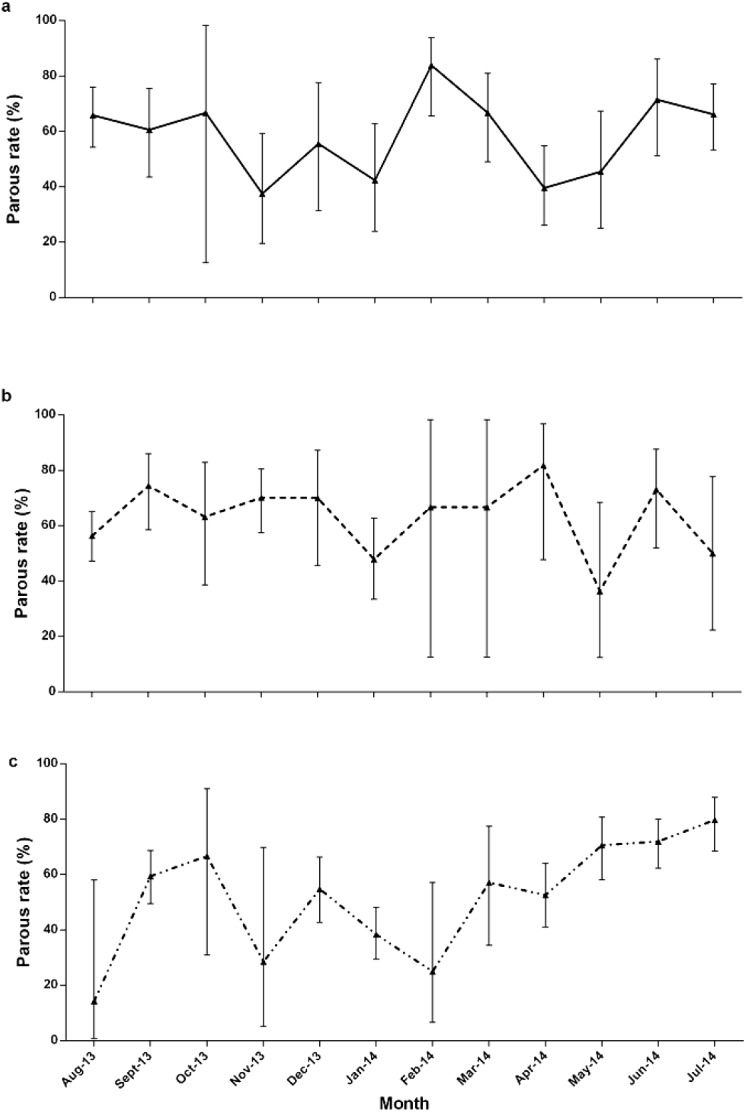
Parous rates (with 95% confidence interval) in three study sites.Alphabet denotes study sites: aLimbuak Laut; bTimbang Dayang; cKg Paradason.